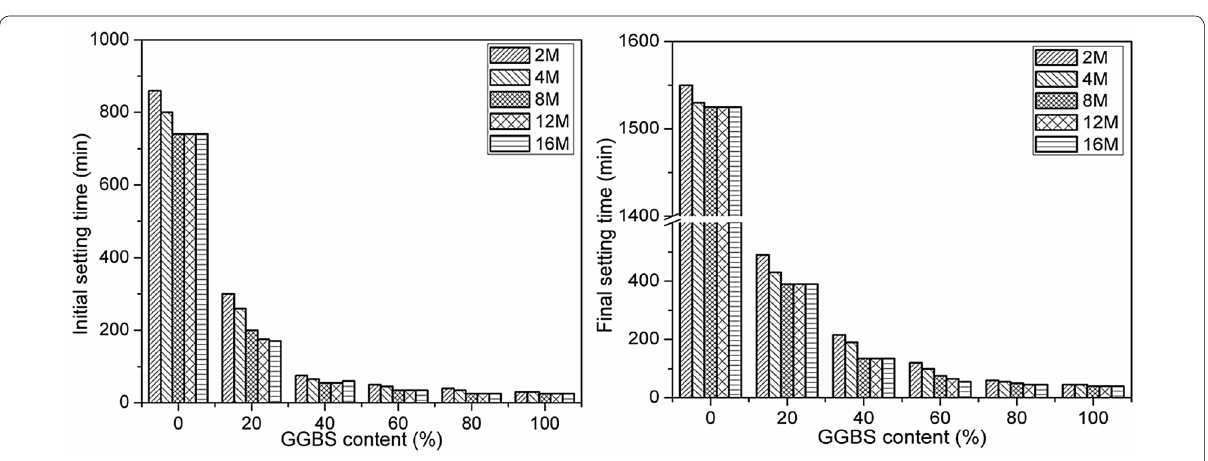
Fig. 1 Setting behaviour of FA-GGBS geopolymers.